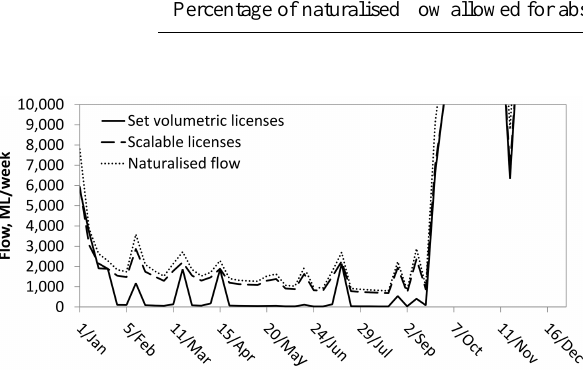
Table 1. Allowable river diversions under the EFI system, defined as a percentage of river flow (source: Environment Agency, 2013). Percentile of natural flow at downstream gauge of the subcatchment